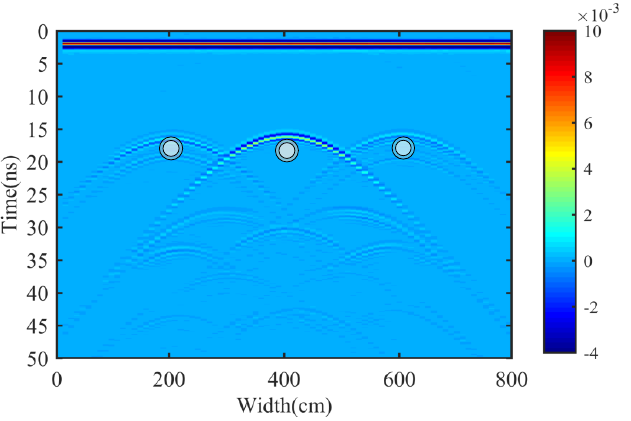
Figure 15. Simulation results of underground multi−pipe model with different pipe materials.